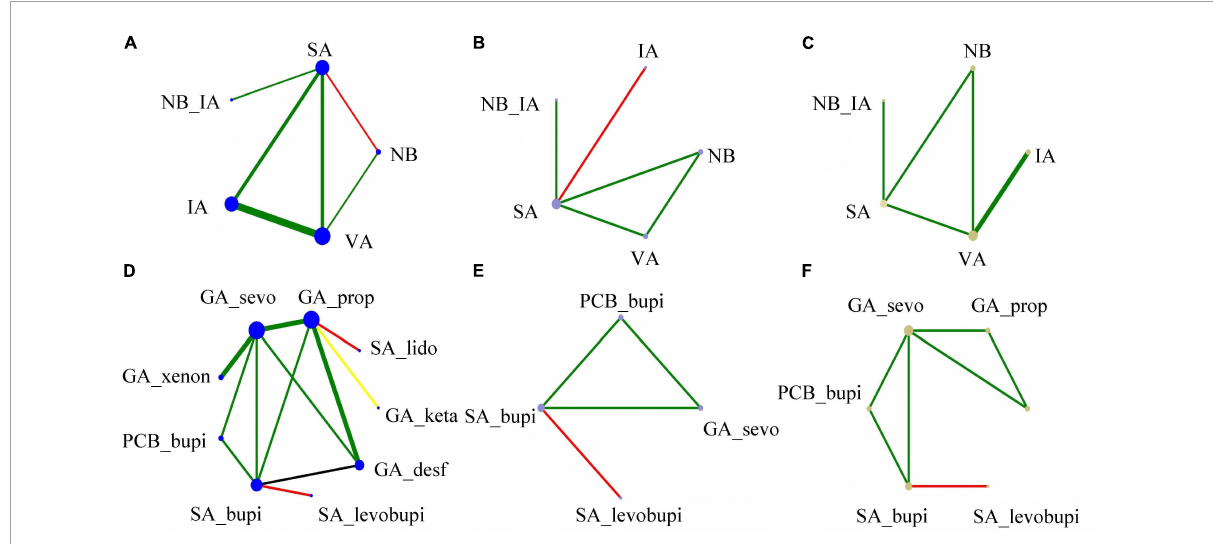
FIGURE2 The network geometry (the incidence of POD) using colored edges according to the risk of bias (Green: low risk; Yellow: unclear; Red: high risk). (A) Delirium occurrence of anesthesia methods; (B) hypotension of anesthesia methods; (C) PONV occurrence of anesthesia methods; (D) delirium occurrence of different anesthetics; (E) hypotension of different anesthetics; (F) PONV occurrence of anesthetics. The size of the node in the network plot represents the sample size of the group, the edge width represents the number of studies, and the color is the risk of bias.